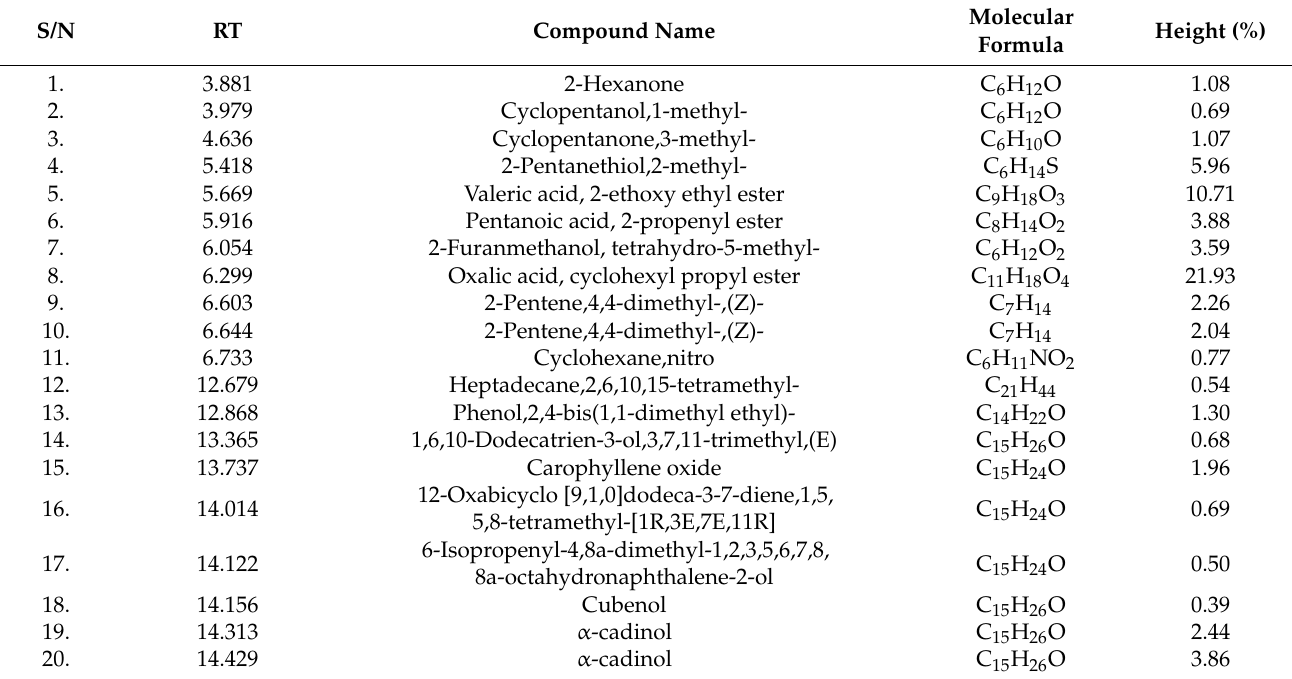
Table 8. Compounds found in the hexane extracts of D. villosa stem by GC–MS spectral